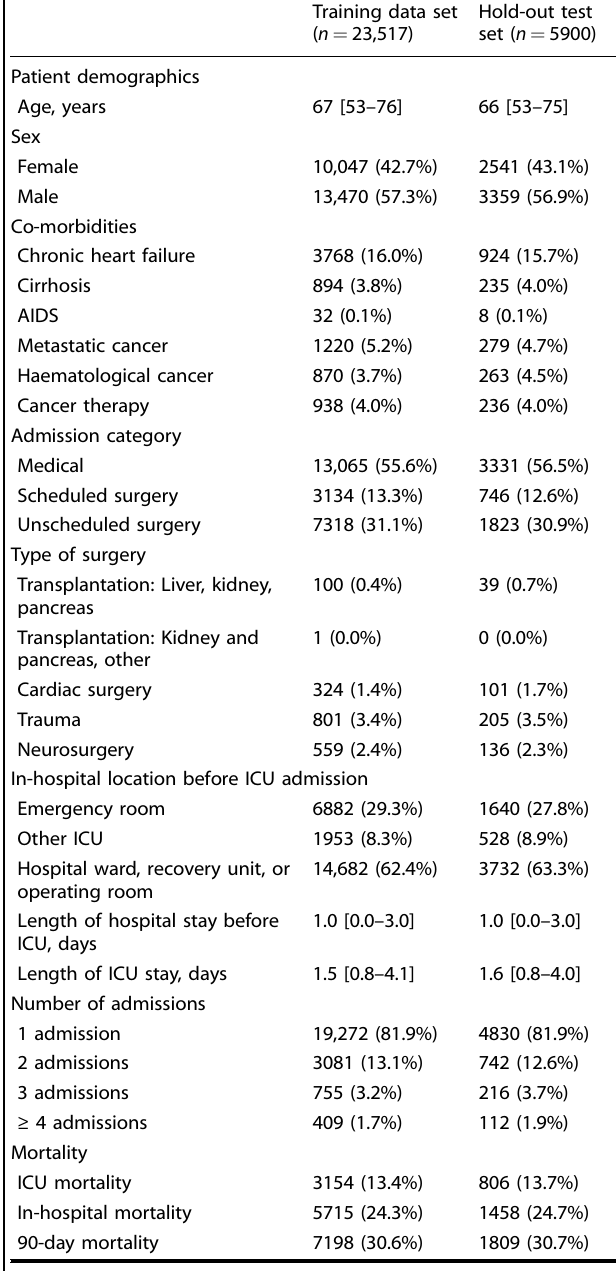
Table 1. Baseline characteristics of ICU patients in the training and hold-out test sets.